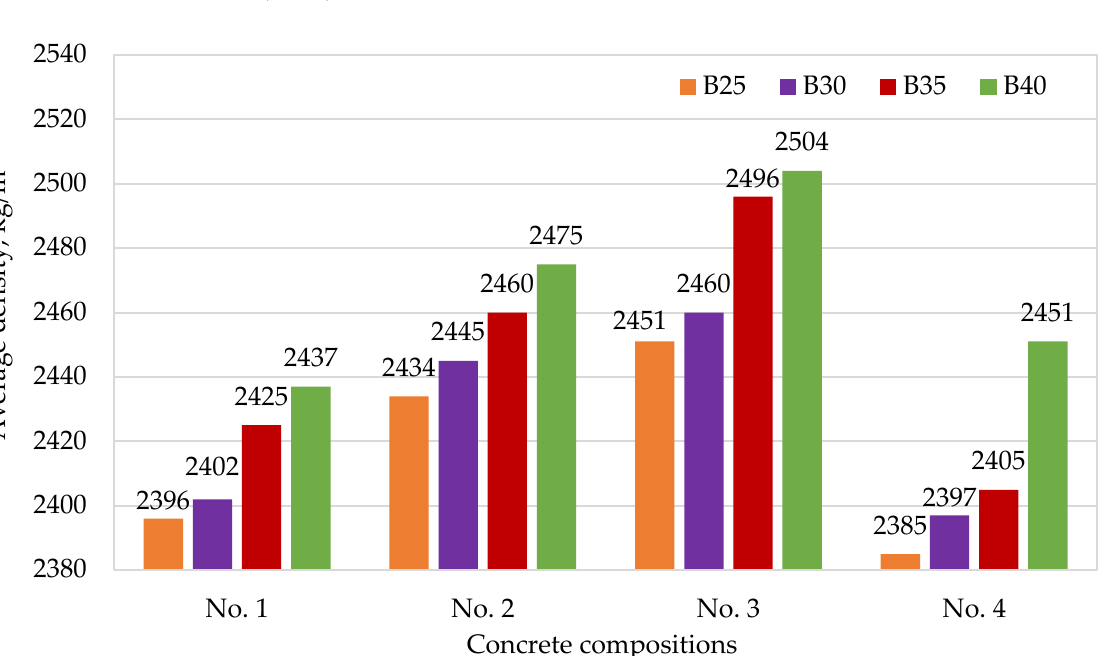
Figure 5. Dependence of concrete density on the application of modifiers and volumetric fiber reinforcement: No. 1—no additives; No. 2—with CCM; No. 3—with CCM and HPC; No. 4—with CCM, HPC, and fiber.